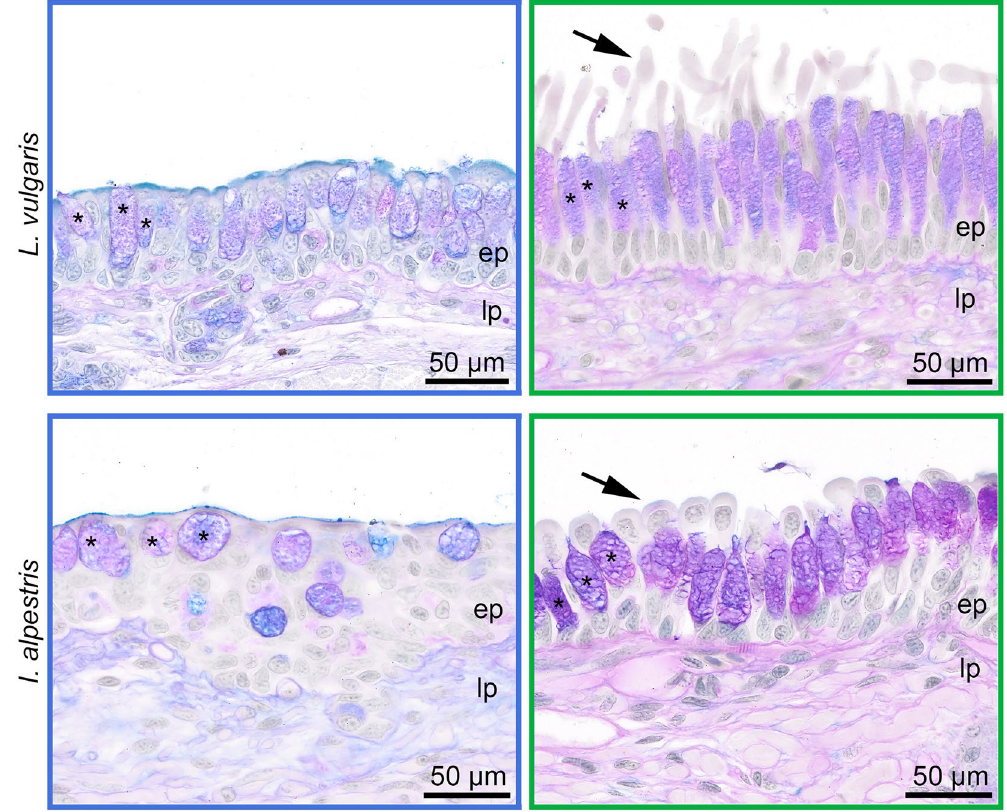
Figure 3. Light micrographs showing the dorsal tongue pad mucosa in the aquatic (blue frames) and terrestrial (green frames) stage in L . vulgaris (top) and I . alpestris (bottom). Note the changes in goblet cell number, goblet cell shape (goblet cells indicated by asterisks) as well as presence (terrestrial stage) and absence (aquatic stage) of the slender papillae (indicated by arrows) on the epithelial surface. Abbreviations: ep, epithelium; lp, lamina propria. Alcian blue-PAS